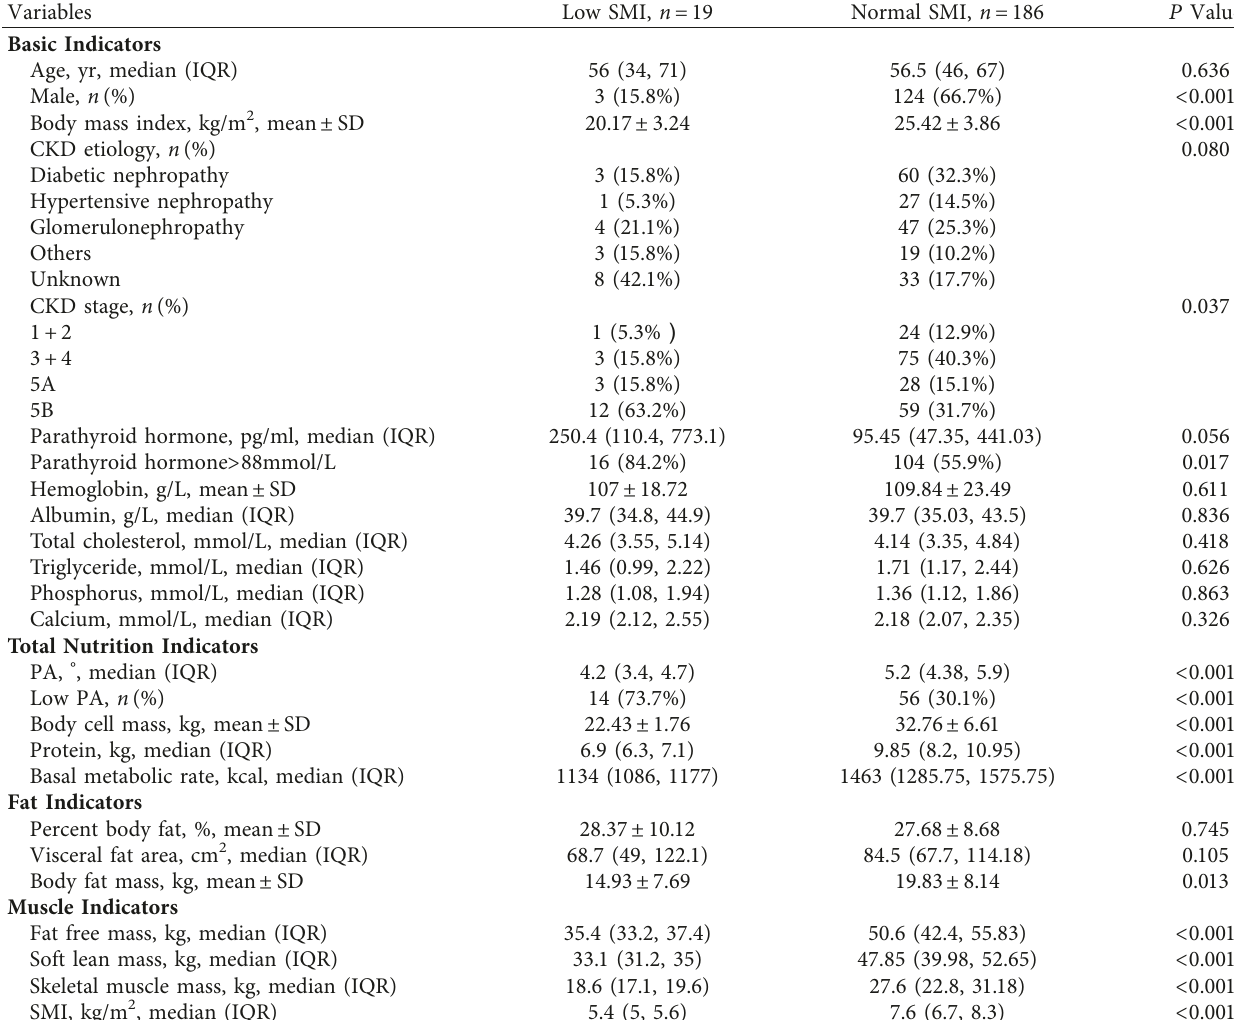
Table 4: Comparison between low and normal SMI groups.